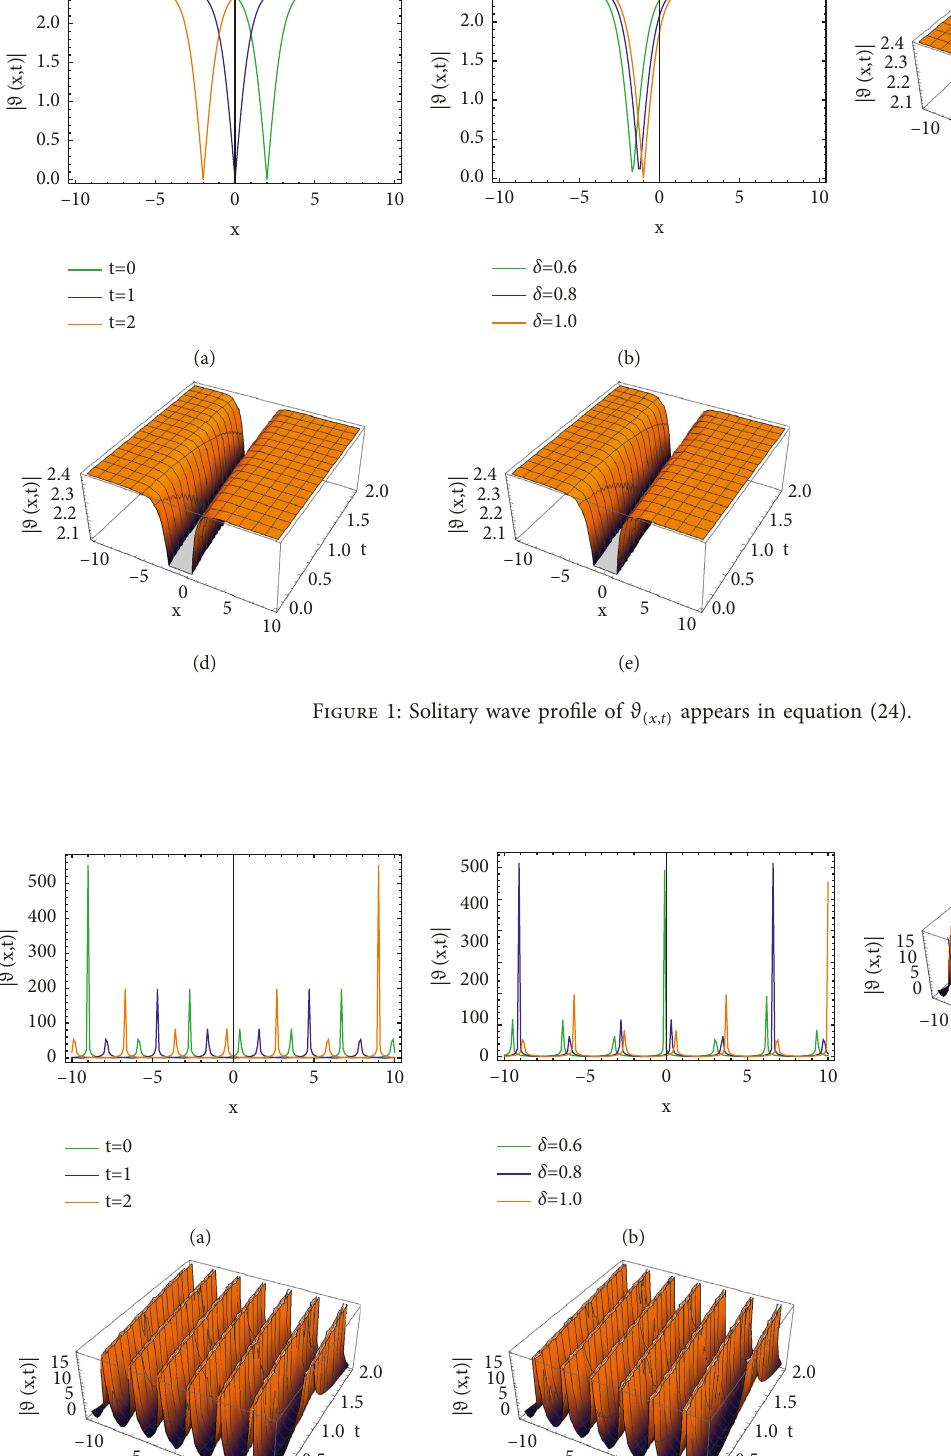
appears in equation x,t ( )